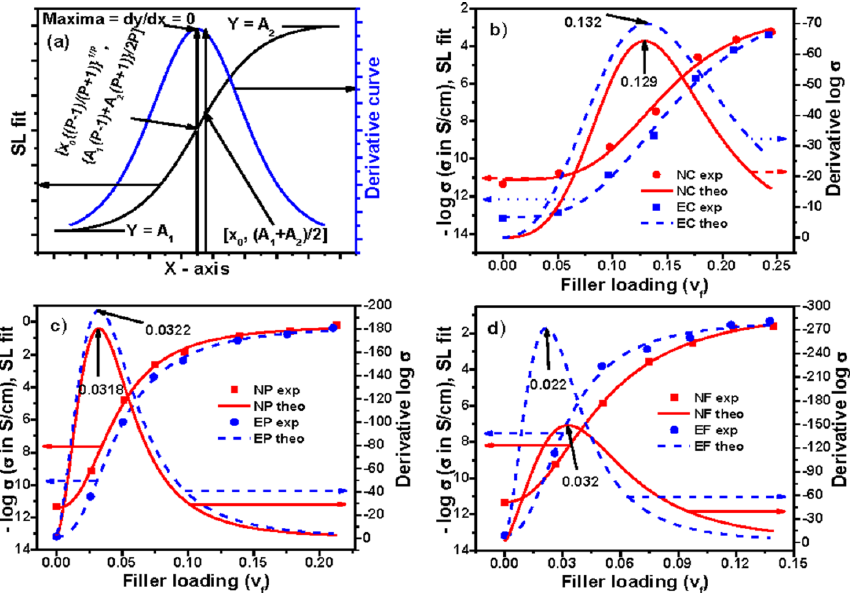
Figure 7. Experimental, theoretical, and derivative curves: ( a ) an ideal curve; ( b ) Conductex black filled; ( c ) Printex black filled; and ( d ) SCF filled composites based on Sigmoidal–Logistic model.